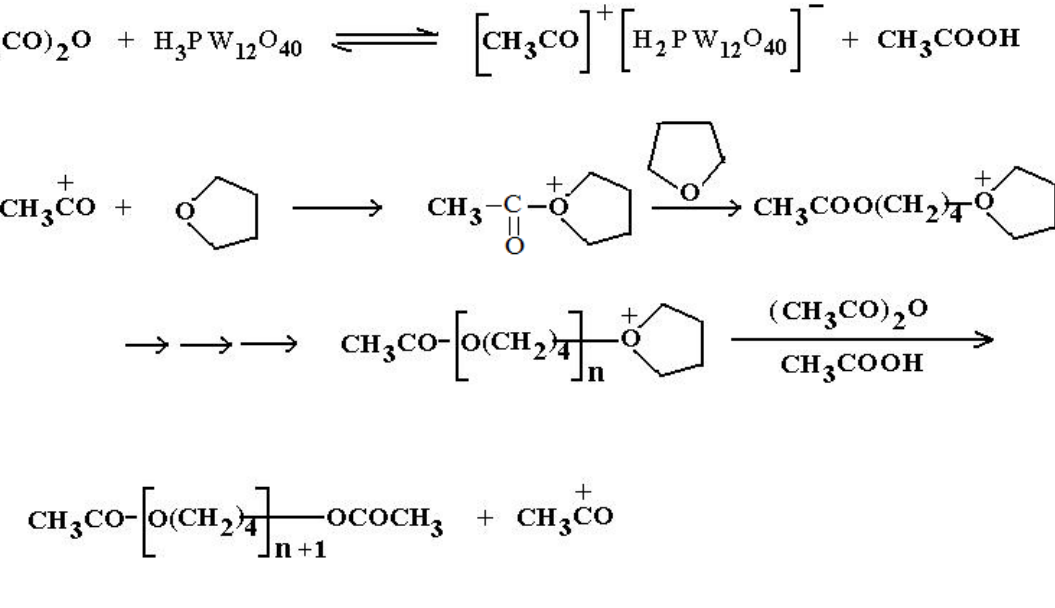
Figure 2. Mechanism of THF ring opening followed by